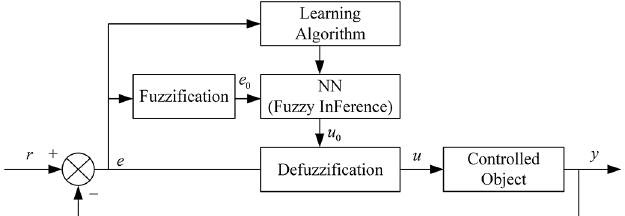
Fig. 14. Schematic of fuzzy neural network intelligent control system for the high-speed elevator based on the Mamdani model.